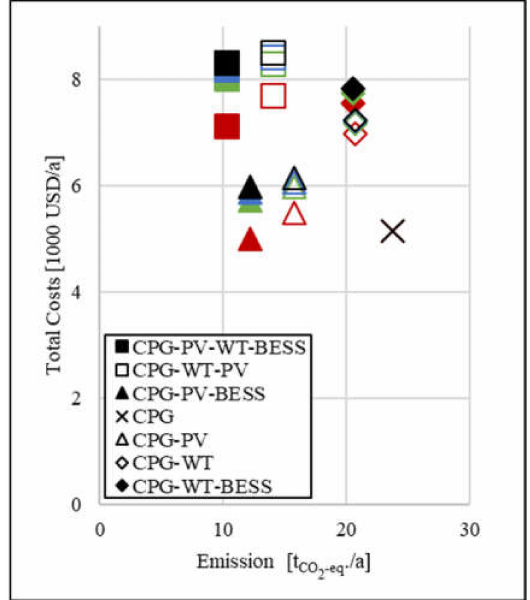
Figure 6. Economic and ecological impact of RES with no (black), 0.009 USD/kg CO2-eq. (blue), 0.02 USD/kg CO2-eq. (green), and 0.08 USD/kg CO2-eq. (red) carbon credits based on the NESSI4D